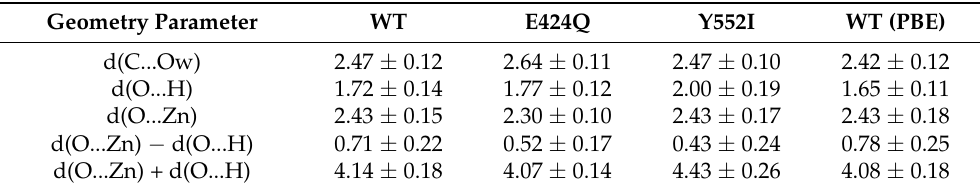
Table 1. Distributions of key interatomic distances from QM/MM MD trajectories at the ES config- uration for the WT, E424Q and Y552I species calculated at the PBE0 level and for the ES WT complex calculated at the PBE level. The distances are in Å.